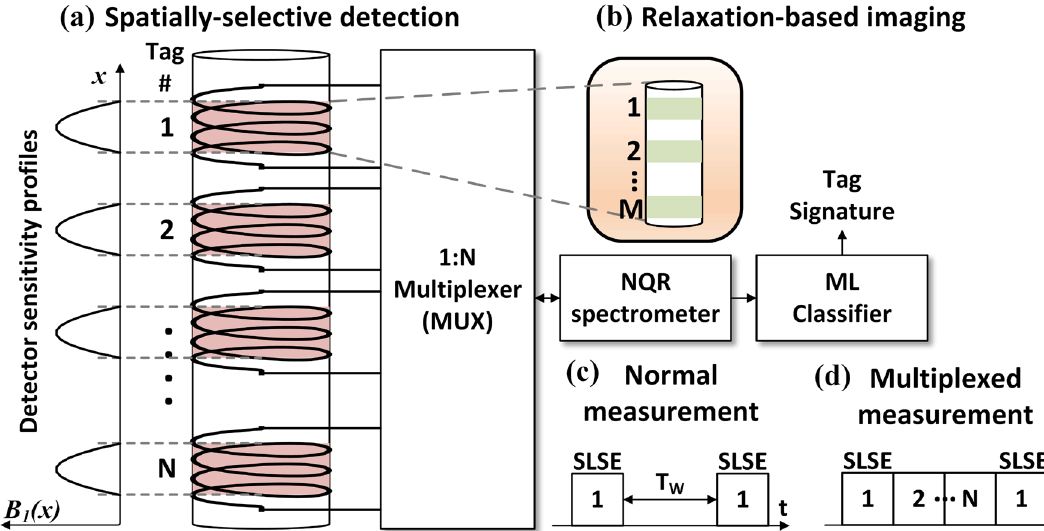
Figure 3. ( a ) Spatially-selective detection using an array of hollow solenoid coils. The system measures signatures from N groups of tags near-simultaneously by using a 1 : N analog multiplexer. ( b ) Signatures from M tags within each group can be measured per scan using relaxation-based imaging. Thus, a total of N tags can be measured by combining the two techniques. ( c ) A normal SLSE pulse sequence for signature read- out which requires a wait-time of T w . ( d ) A multiplexed SLSE pulse sequence that allows signature from other tags to be acquired during T w [Microsoft